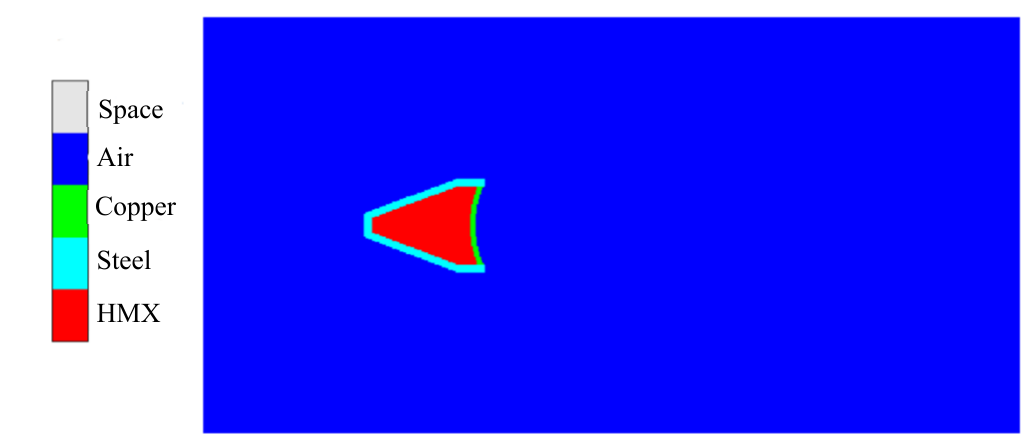
Figure 6. EFP model used in the research (Autodyn) [8]